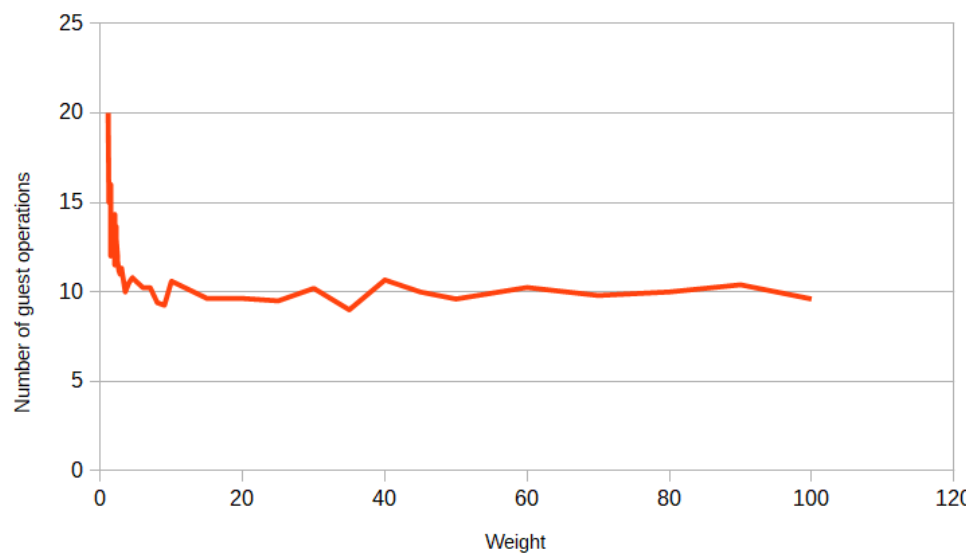
Figure 3. The dependency of the number of guest surgeries on the weight w 0 , 1 ≤ w o ≤ 100.